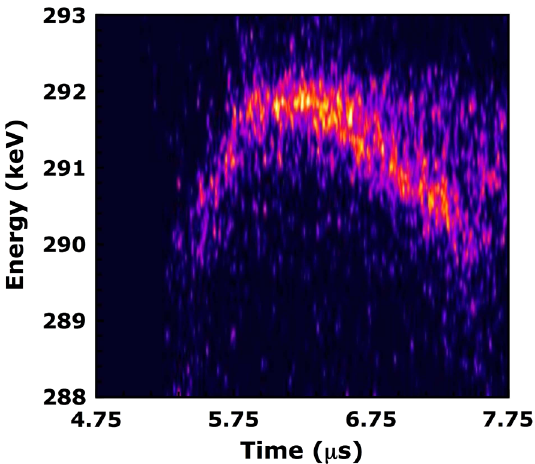
FIG. 7. Longitudinal phase space distribution of the NDCX beam with a 3 (cid:1) s pulse streaked in